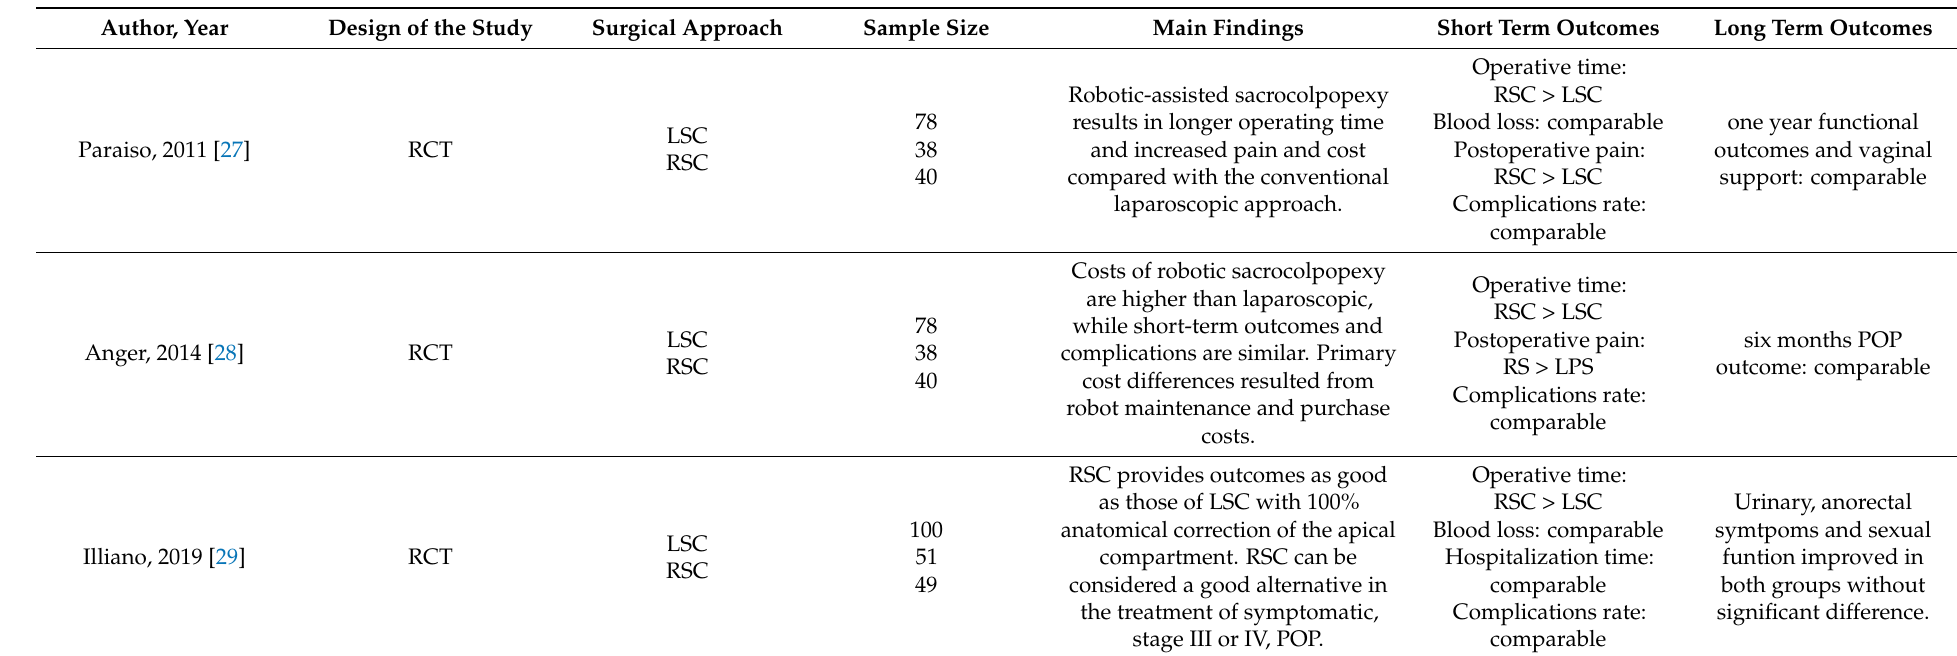
Table 4. Robotic pelvic organ prolapse treatment